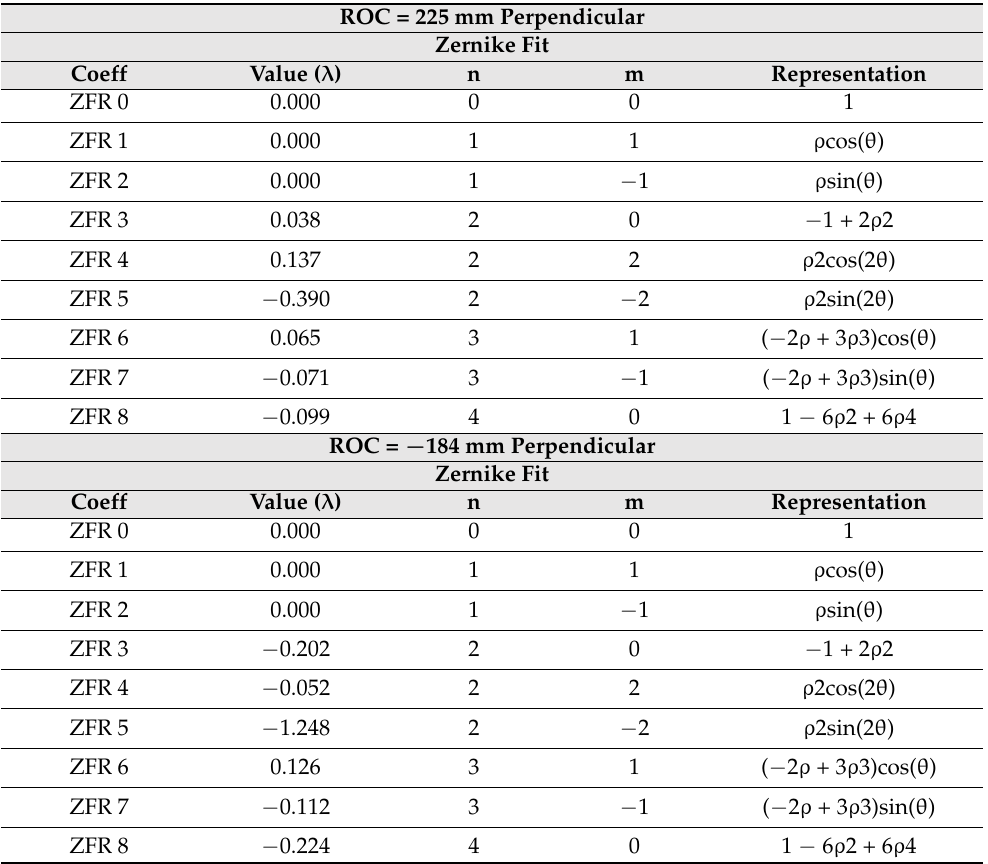
Table 2. Results from the Zernike fit coefficients obtained from the data in Figure 7, for positive ROC (top) and negative ROC (bottom).